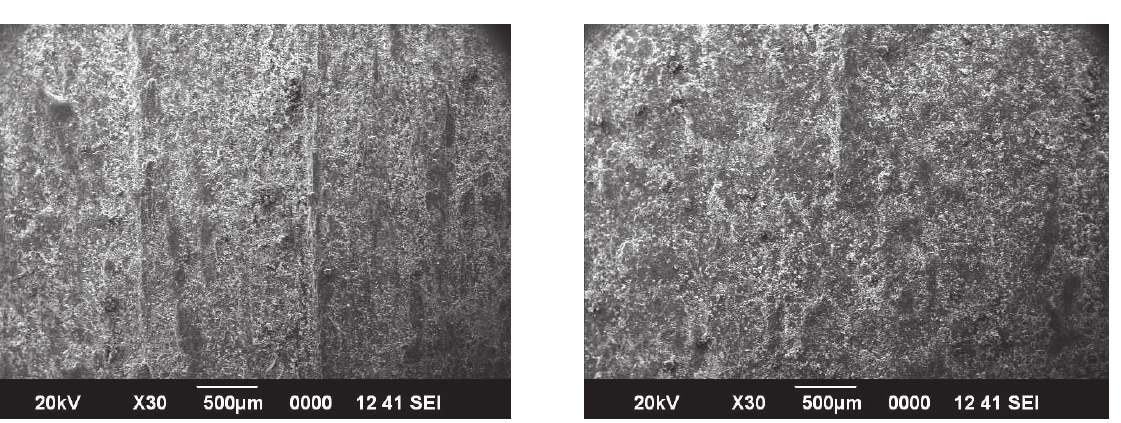
Fig. 10. SEM image of composite after